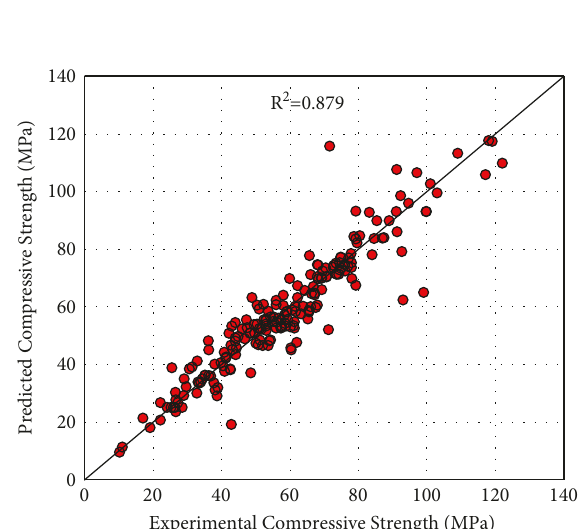
Figure 8: Experimental vs. forecasted compressive strengths for ANN-PSO-2L (10-8) model for all data.